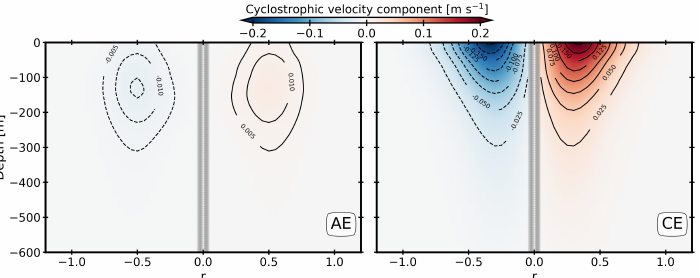
Figure 10. The cyclostrophic component for the CE and AE. Dashed and solid contours indicate negative and positive values, respectively.